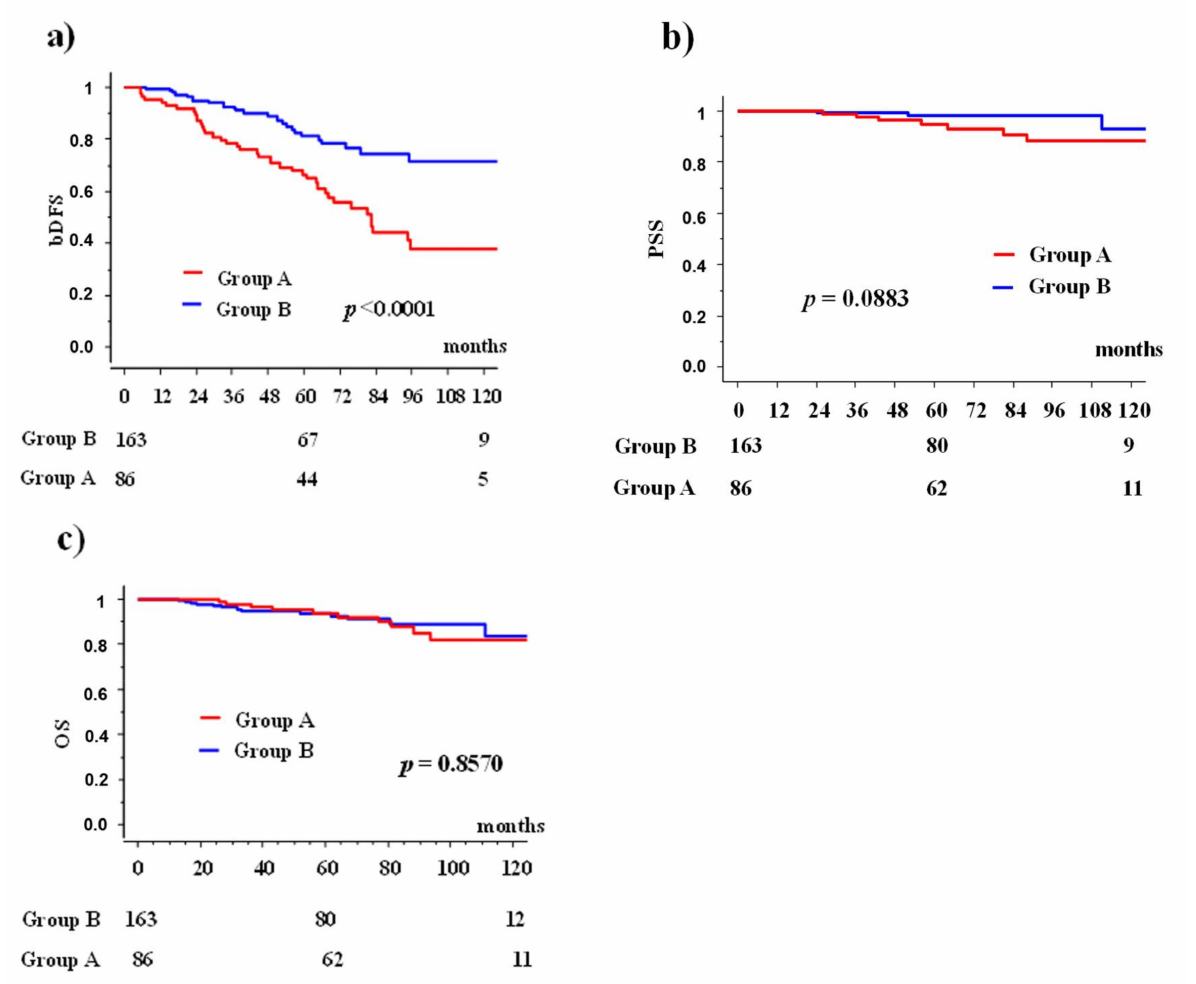
Figure 2. Biochemical disease-free rate (bDFS), prostate cancer specific survival rate (PSS), and overall survival rate between group A and B; ( a ) biochemical control rates; ( b ) prostate cancer specific survival rate; and ( c ) overall survival